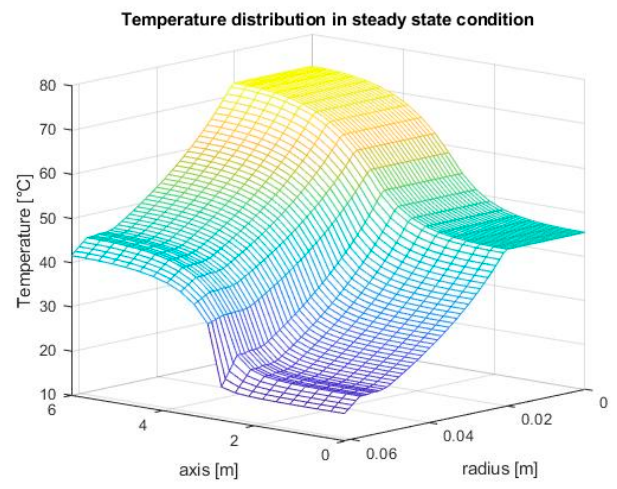
Figure 5. Temperature vs. radius and axis in steady state conditions—Scenario E.